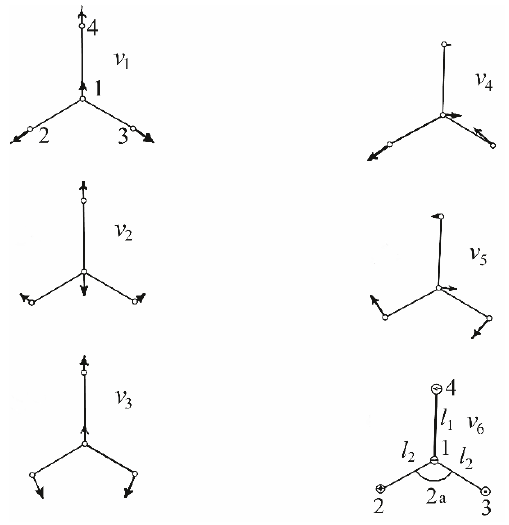
Figure 2. Molecular vibrations of, e.g., H 2 CO.